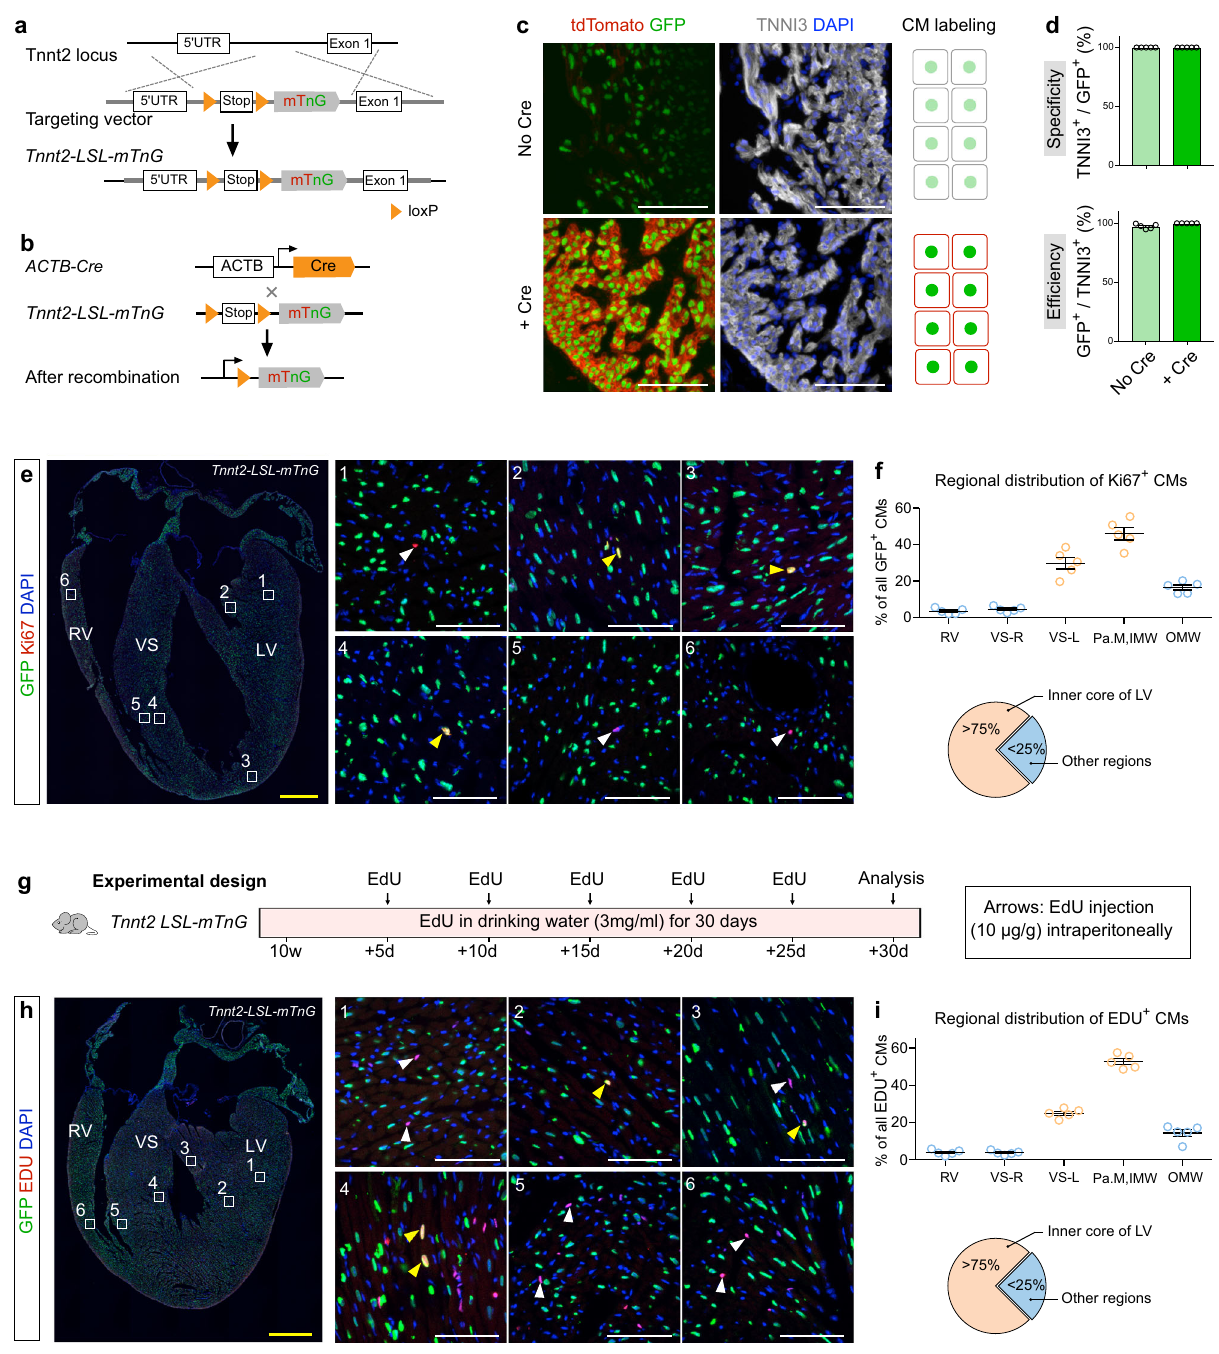
Fig. 6 Cardiomyocyte-speci fi c Ki67 protein expression and EdU incorporation are more enriched in inner core of left ventricle. a Schematic fi gure showing generation of Tnnt2-loxP-Stop-loxP-membrane tdTomato-2A-nuclear GFP ( Tnnt2-LSL-mTnG ) mouse line. b Strategy of crossing Cre line with Tnnt2-LSL-mTnG line. c Immunostaining for GFP, tdTomato, and TNNI3 on heart tissue sections of E13.5 Tnnt2-LSL-mTnG embryos containing Cre or no Cre. Cartoon shows labeling of cardiomyocytes (CM) in no Cre or Cre embryos. d Quanti fi cation of the GFP labeling speci fi city and ef fi ciency in Tnnt2-LSL- mTnG containing Cre or no Cre embryos. Data are mean ± s.e.m.; n = 5. e Immunostaining for Ki67 and GFP on Tnnt2-LSL-mTnG heart sections (10 weeks). Boxed regions (1 – 6) are magni fi ed on the right panel. Yellow arrowheads, nGFP + Ki67 + CMs; white arrowheads, nGFP – Ki67 + nuclei. f Quanti fi cation of the distribution of nGFP + Ki67 + CMs in different regions of hearts. Data are mean ± s.e.m.; n = 5. g Schematic fi gure showing the experimental design. h Immunostaining for GFP and EdU on heart sections (14 weeks). Boxed regions (1 – 6) are magni fi ed on the right panel. Yellow arrowheads, nGFP + EdU + CMs; white arrowheads, nGFP – EdU + nuclei. i Quanti fi cation of the distribution of nGFP + EdU + CMs in different regions of hearts. Data are mean ± s.e.m.; n = 5. Each image is representative of fi ve individual biological samples. Scale bars: yellow, 1 mm; white, 100 µ